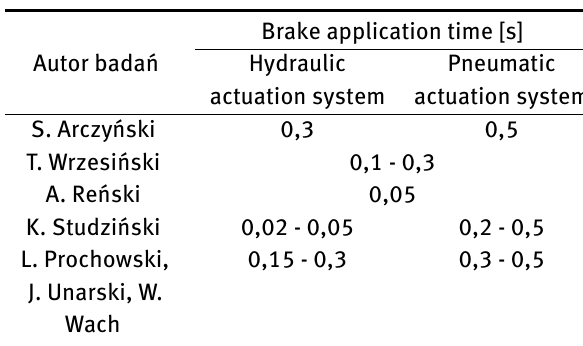
Table 3: Example of the delay build-up time [3].